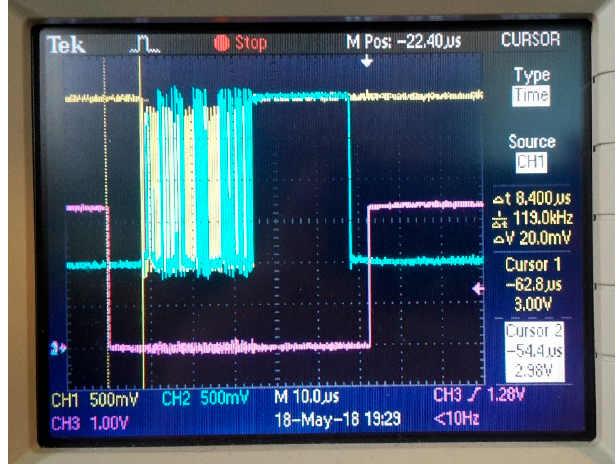
Figure 6. Oscilloscope snapshot showing the time delay of 8.4 µs between the falling edge of the ADC interrupt signal and the start of the encoder polling transmission command where the yellow trace is the encoder clock, blue trace is the encoder data and red trace is the ADC interrupt signal.